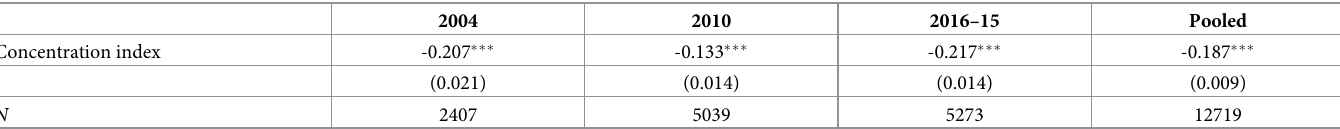
Table 3. Concentration indices for teenage pregnancy and childbearing.